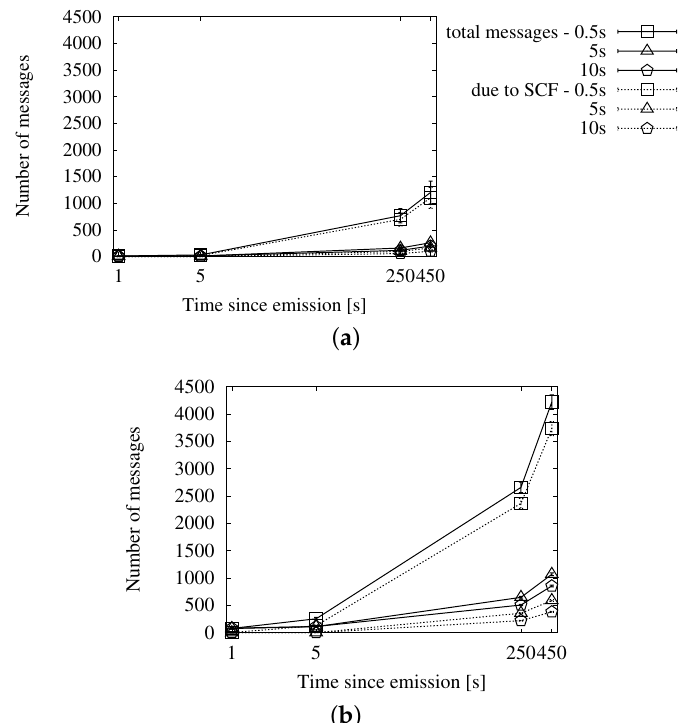
Figure 11. Sent messages with the fixed interval approach for store-carry-forward in the New York scenario: ( a ) roadway scheme, 25 vehicles/km 2 ; ( b ) roadway scheme, 100 vehicles/km 2 .